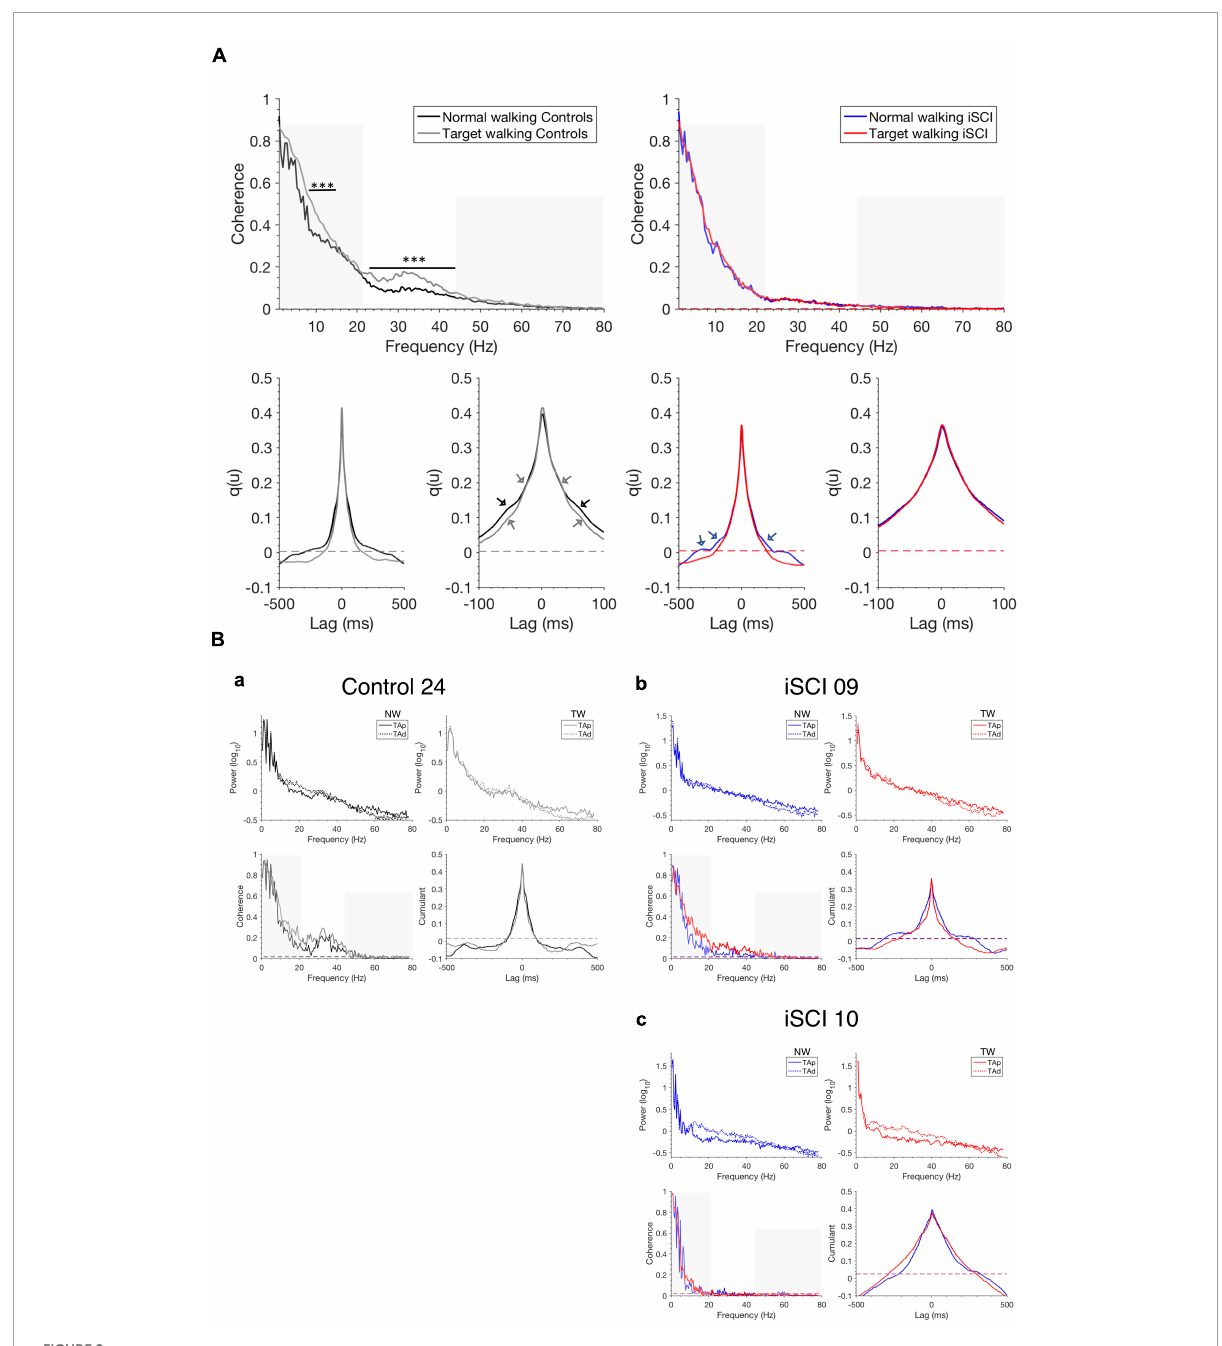
FIGURE2 Pooled coherence estimates, single-participant coherence, and cumulant densities during walking. (A) Pooled TAp-TAd coherence estimates for controls during NW (black) and TW (gray) (top left) and individuals with iSCI during NW (blue) and TW (red) (top right) and the corresponding cumulants are shown (bottom with expanded lag scales in second and fourth position). The non-shaded area indicates the high-frequency range (21–44 Hz) of interest. The pooled cumulant densities are zoomed to allow for better visualization of secondary features (see arrows). Dashed horizontal lines indicate the upper 95% confidence interval limits. (B) Single TAp-TAd coherence estimates, power spectra and cumulant densities for (a) a control (Control 24) who shows a median effect of increased mean high-frequency intramuscular coherence (non-shaded area) during TW compared to NW. iSCI 09 (b) shows high mean high-frequency coherence (non-shaded area) during TW while iSCI 10 (c) shows the lowest mean high-frequency coherence (non-shaded area) during TW. Dashed horizontal lines indicate the upper 95% confidence interval limits. The non-shaded area in the single coherence estimates presents the frequency range of interest 21–44 Hz. Note that the y -scale is different for the power spectra in (Ba–c) . iSCI, incomplete spinal cord injury; TAp, Tibialis anterior proximal; TAd, Tibialis anterior distal; NW, Normal walking; TW, Target walking. *** P <